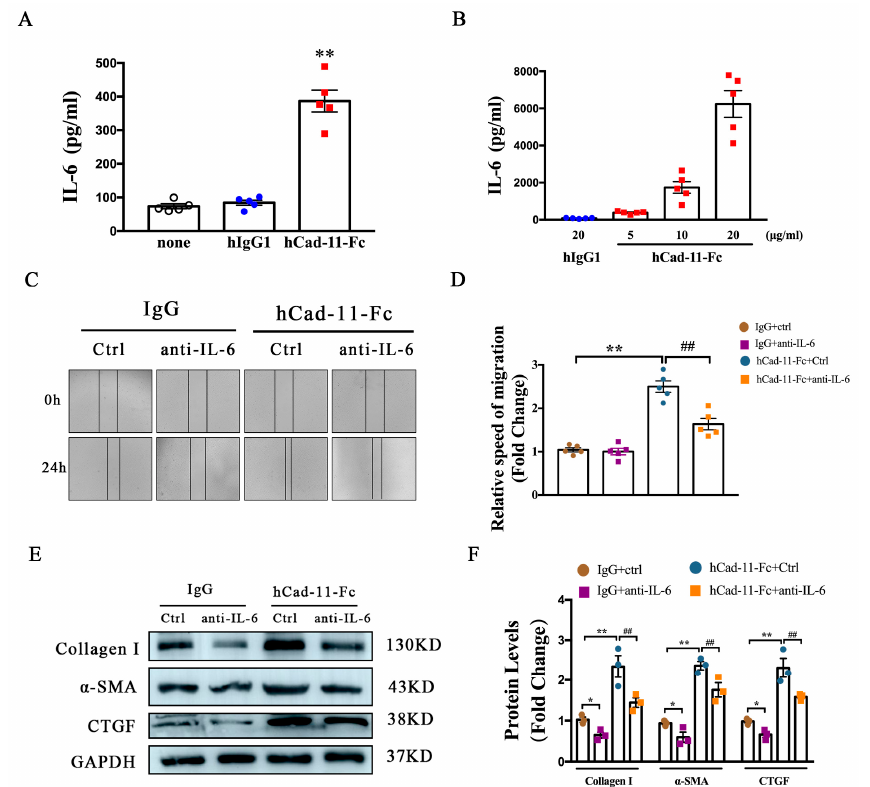
Figure 5. IL-6 participates in Cad-11-induced cardiac fibroblast activation. ( A ) The IL-6 protein levels determined by ELISA in primary cardiac fibroblasts treated with 5 µ g/mL hCad-11-Fc, hIgG1, or PBS for 48 h. ( B ) Primary cardiac fibroblasts were cultured with 20 µ g/mL hIgG1 or the indicated concentrations ( µ g/mL) of hCad-11-Fc for 48 h and the supernatants were analyzed for IL-6 by ELISA ( n = 5 in each group). ( C , D ) Representative images of wound-healing assay in CFs captured at 0 and 24 h with or without the stimulation of hCad-11-Fc and anti-IL-6. Scale bar, 100 µ m. The relative speed of fibroblast migration was measured by its mean linear movement over wound edges at 24 h ( n = 5 in each group). ( E , F ) Representative immunoblots and statistics of fibrosis-related protein levels with or without the stimulation of hCad-11-Fc and anti-IL-6 measured by western blotting. Data were presented as mean ± SEM, * p < 0.05, ** p < 0.01 vs. the hIgG group, IgG+Ctrl group. ## p < 0.01 vs. hCad-11-Fc+Ctrl group.